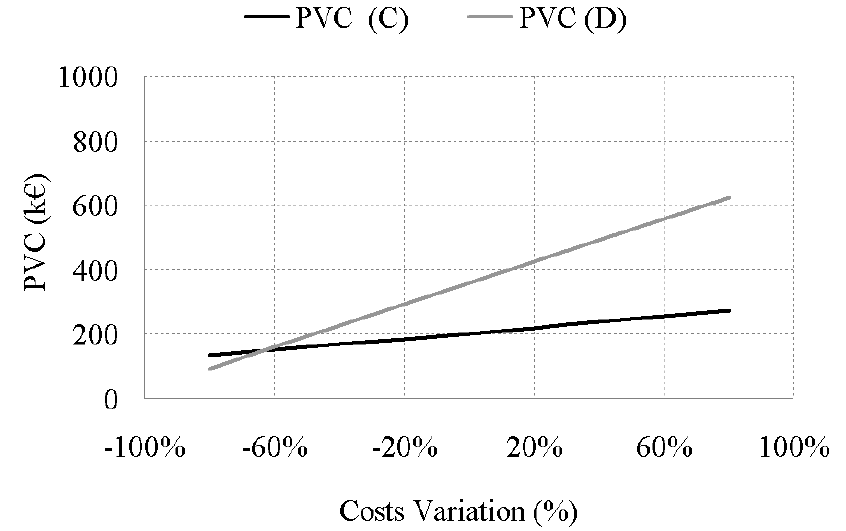
Figure 6. Sensitivity analysis related to the variation of the PVC of the two heating systems (C = wood chips heating system; D = Diesel heating system), in relationship with the variation percentage of the gas-oil price and wood chips production